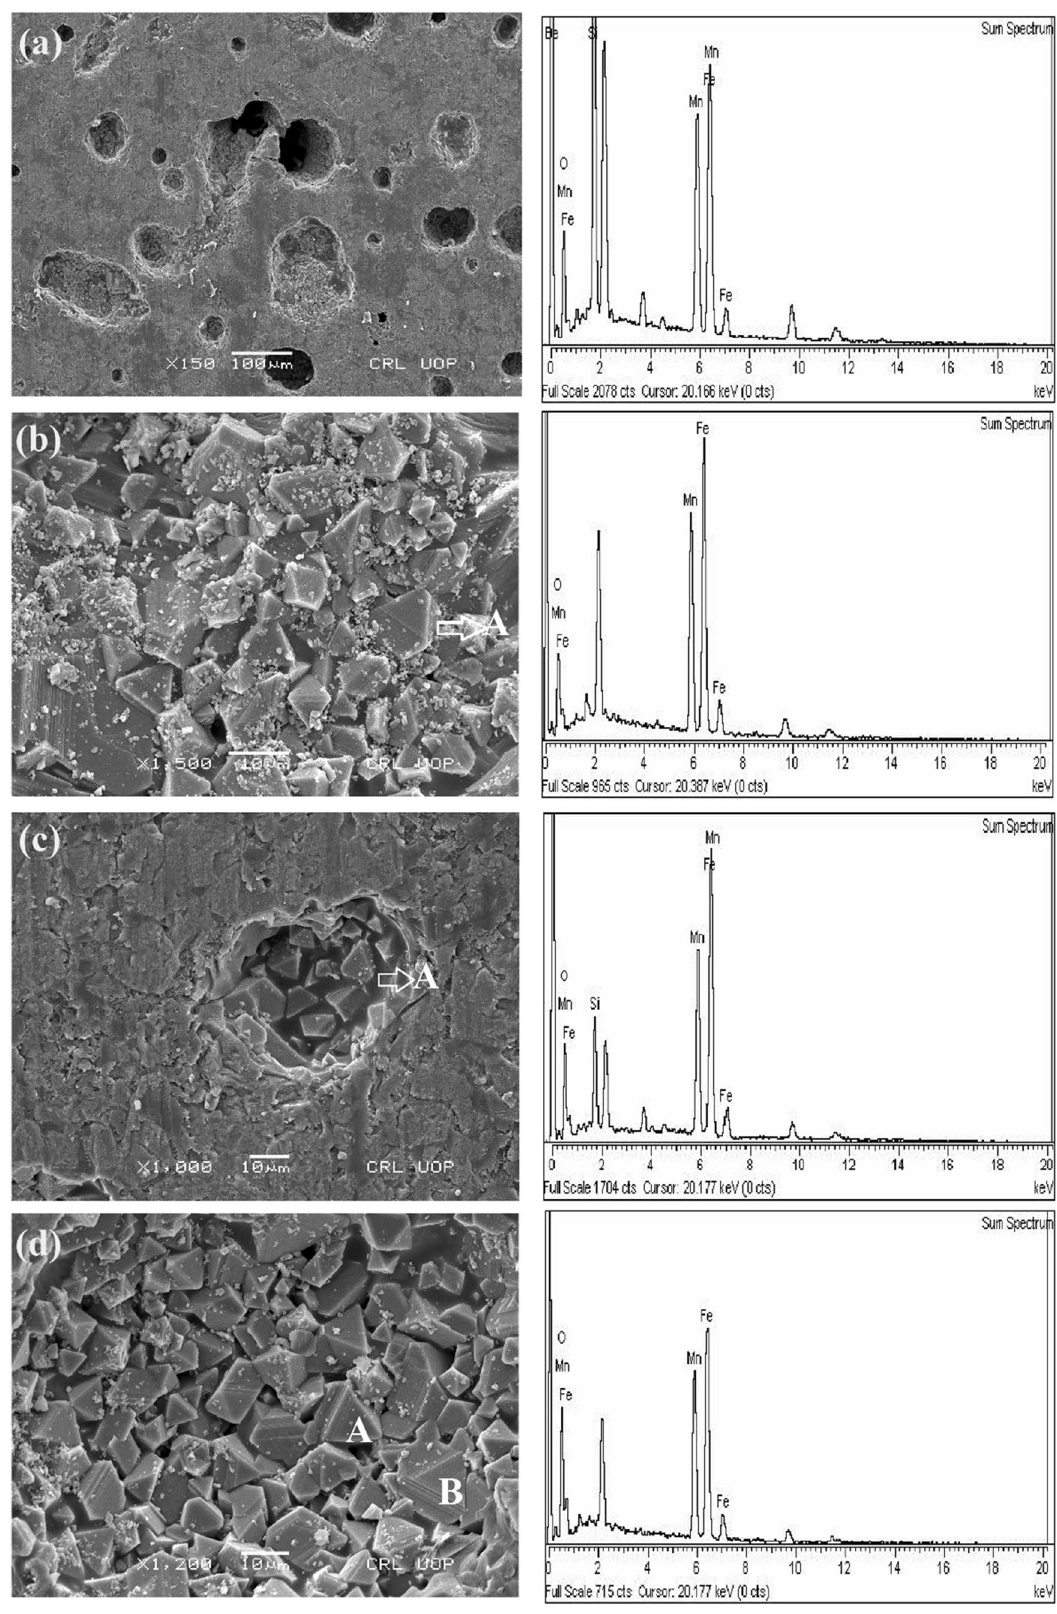
Figure 2. SEM micrographs of the manganese ferrite showing a spongy type, fragile and fractured surface ( a ), highly compact pyramidal and triangular grains ( b–d